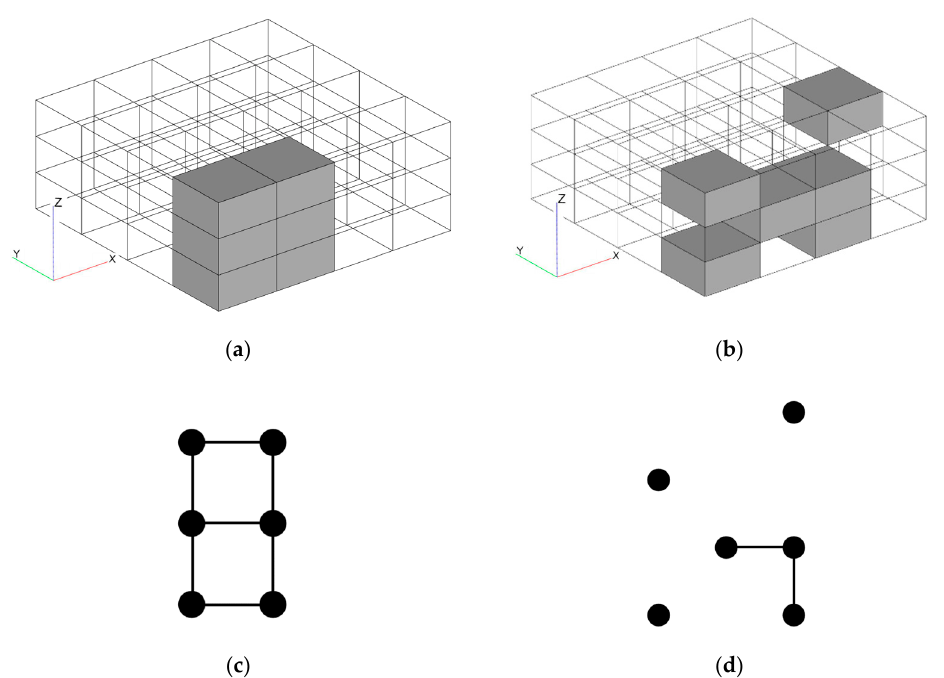
Figure 5. Compact batch ( a ) and a batch that is not compact ( b ). Underlying incidence graph ( c ) of the compact batch ( a ). Underlying incidence graph ( d ) of a batch that is not compact ( b